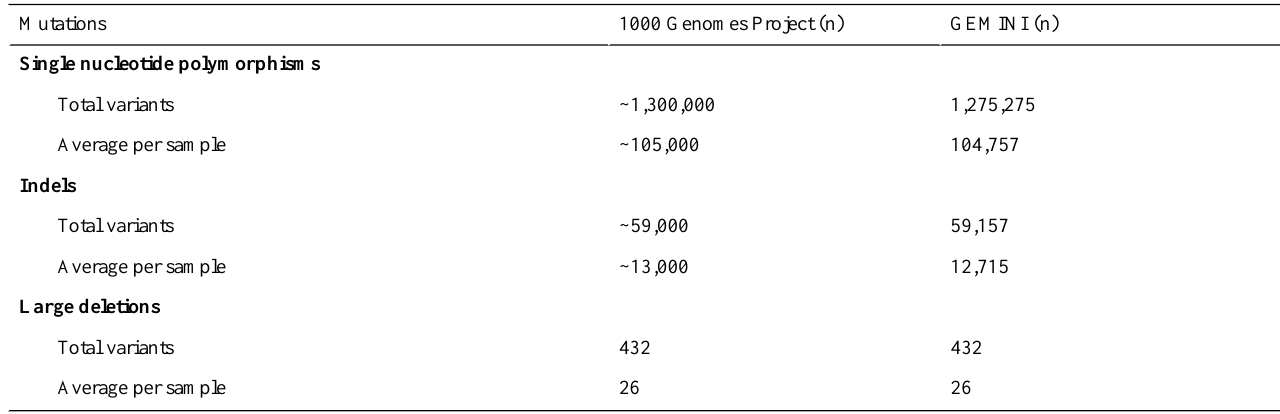
Table 1. Comparison of the statistical evaluation of the 1000 Genomes Project and GEMINI (GEnome MINIng)